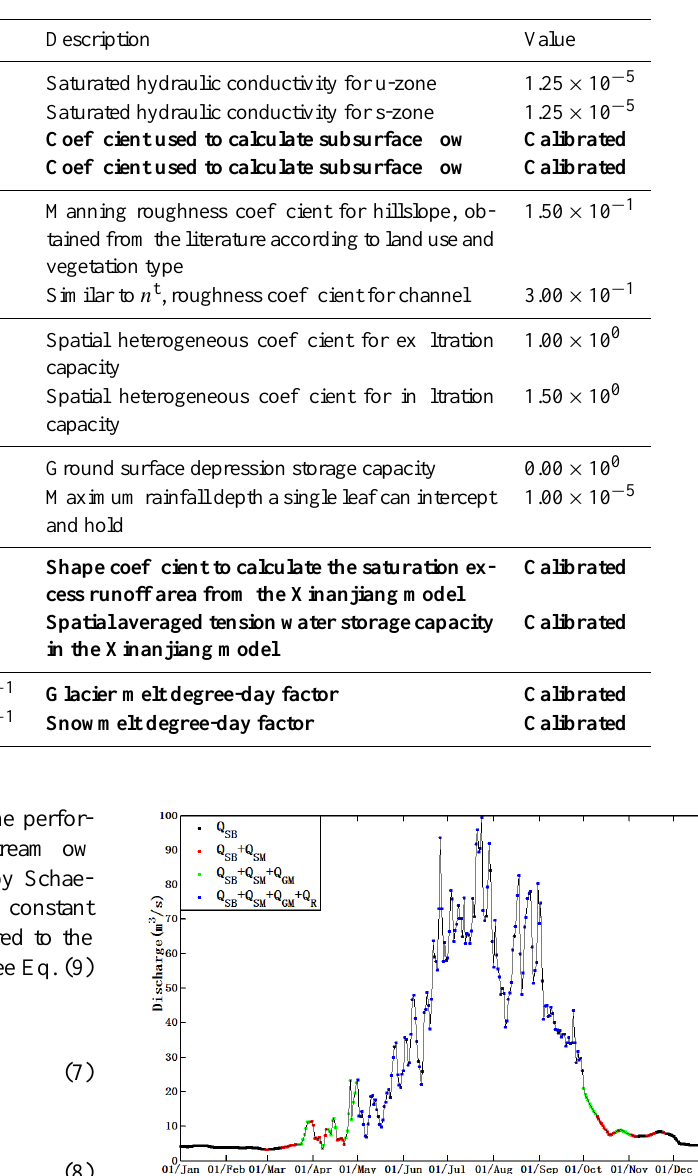
Table 3. Grouped parameters in the THREW model. Parameters subjected to calibration are highlighted in bold.